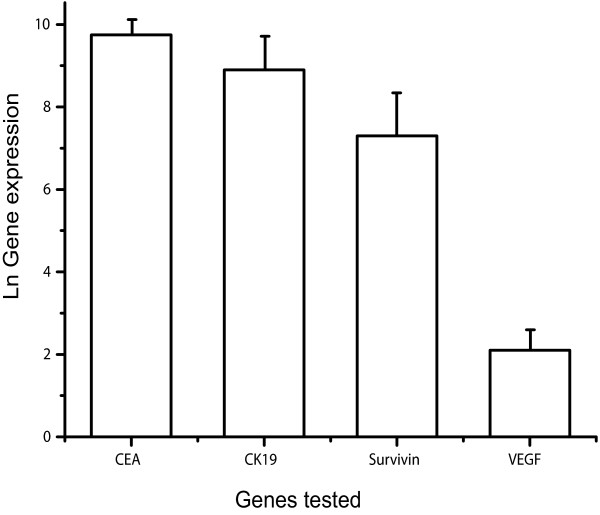
Gene expression levels of the four genes of interest in N87 human gastric cancer cells (as measured by quantitative real time PCR: see text for details). The natural logarithm of the expression levels is reported on the y axis: the axis origin (0) represents the reference sample (called calibrator) with which all experimental samples are compared in the relative quantification method (see text for details).